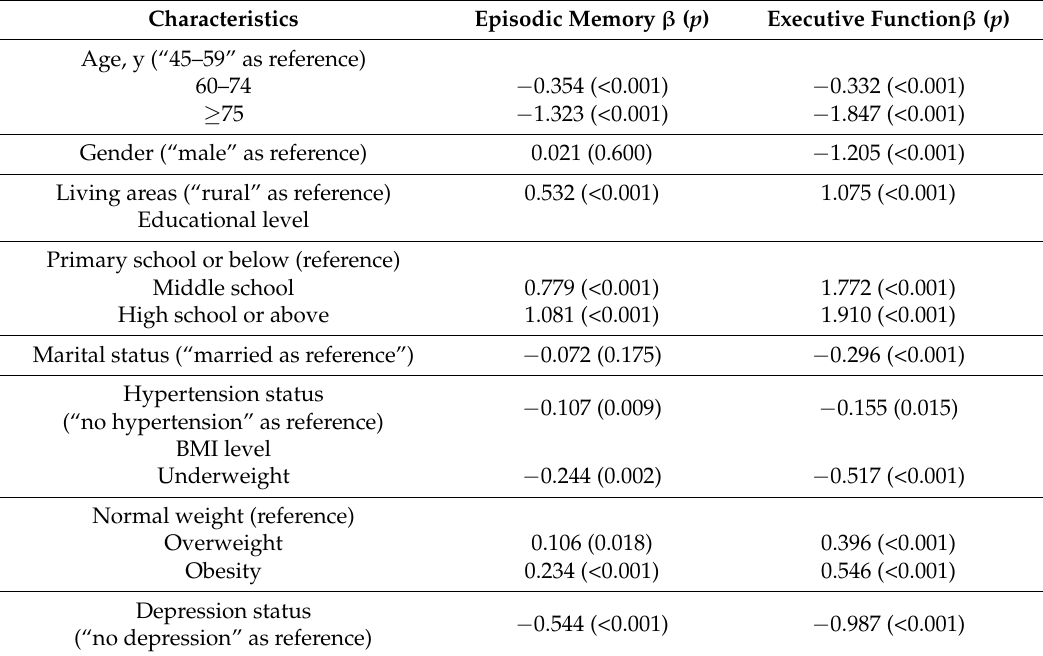
Table 2. Correlation between covariates and cognition in full sample (n = 8535).